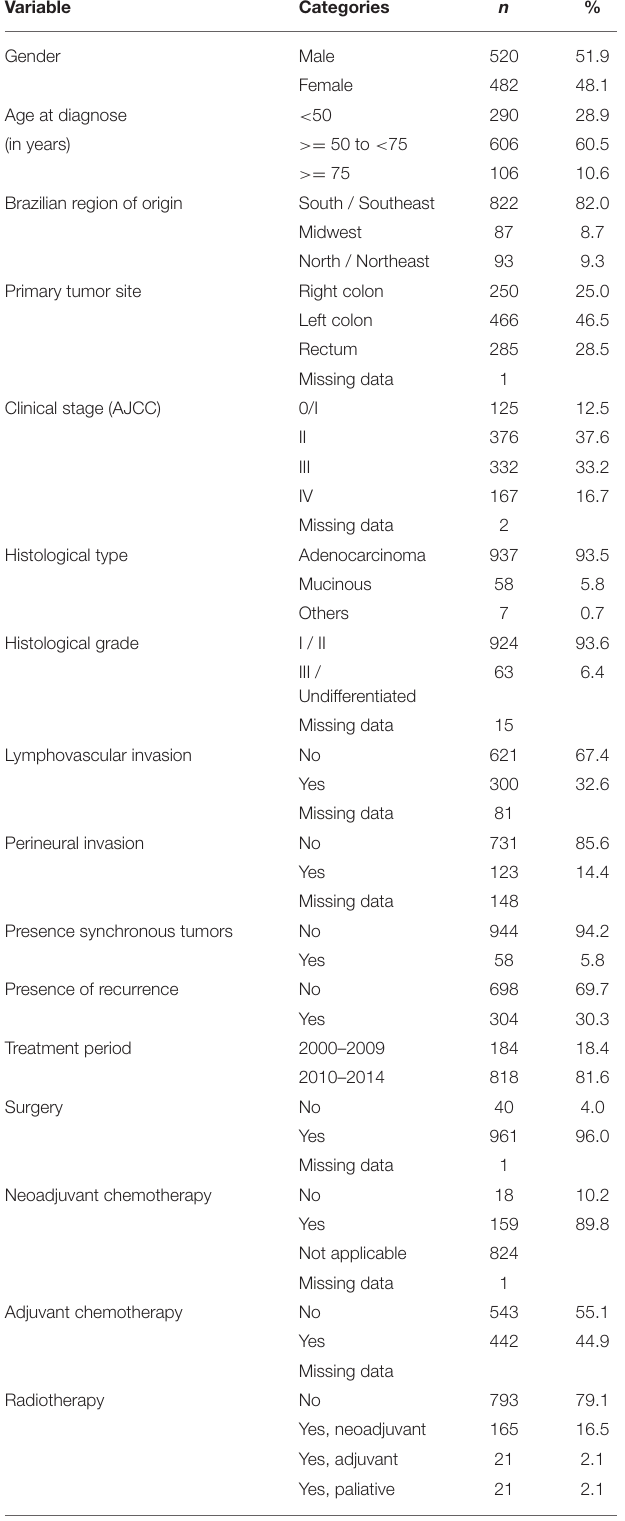
TABLE 1 | Ancestry background categorization according to tercile based on percentage proportions for all four ethnic groups. Ancestry components